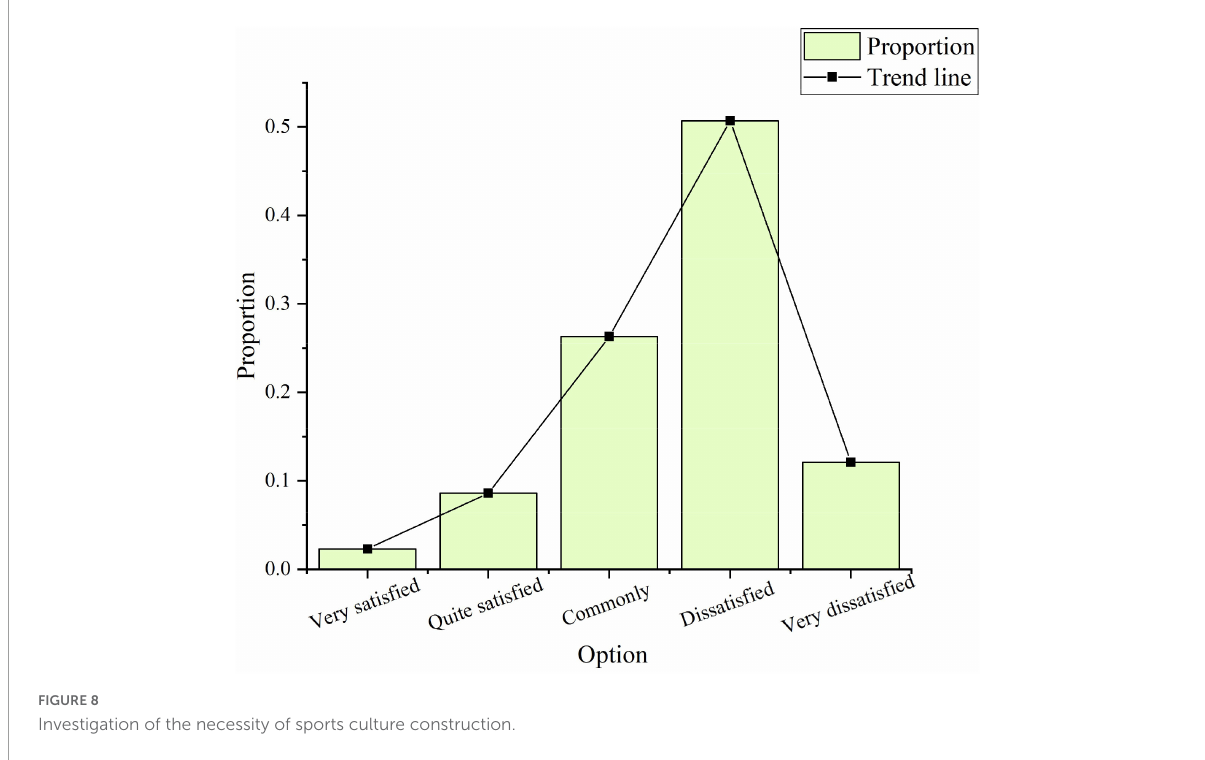
FIGURE8 Investigation of the necessity of sports culture construction.